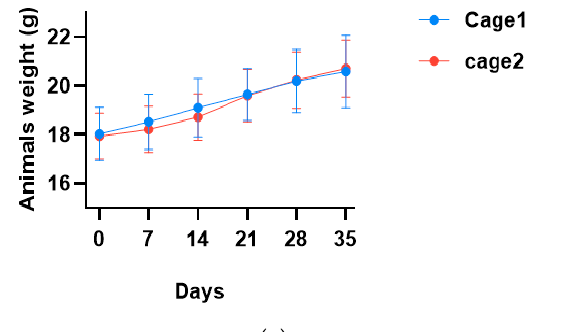
Figure 2. ( a ) Size distribution of vesicles. The vesicles are physically stable for periods up to 10 days; ( b ) composition of TFAs in nanovesicles. The vesicles were chemically stable for periods up to 10 days.